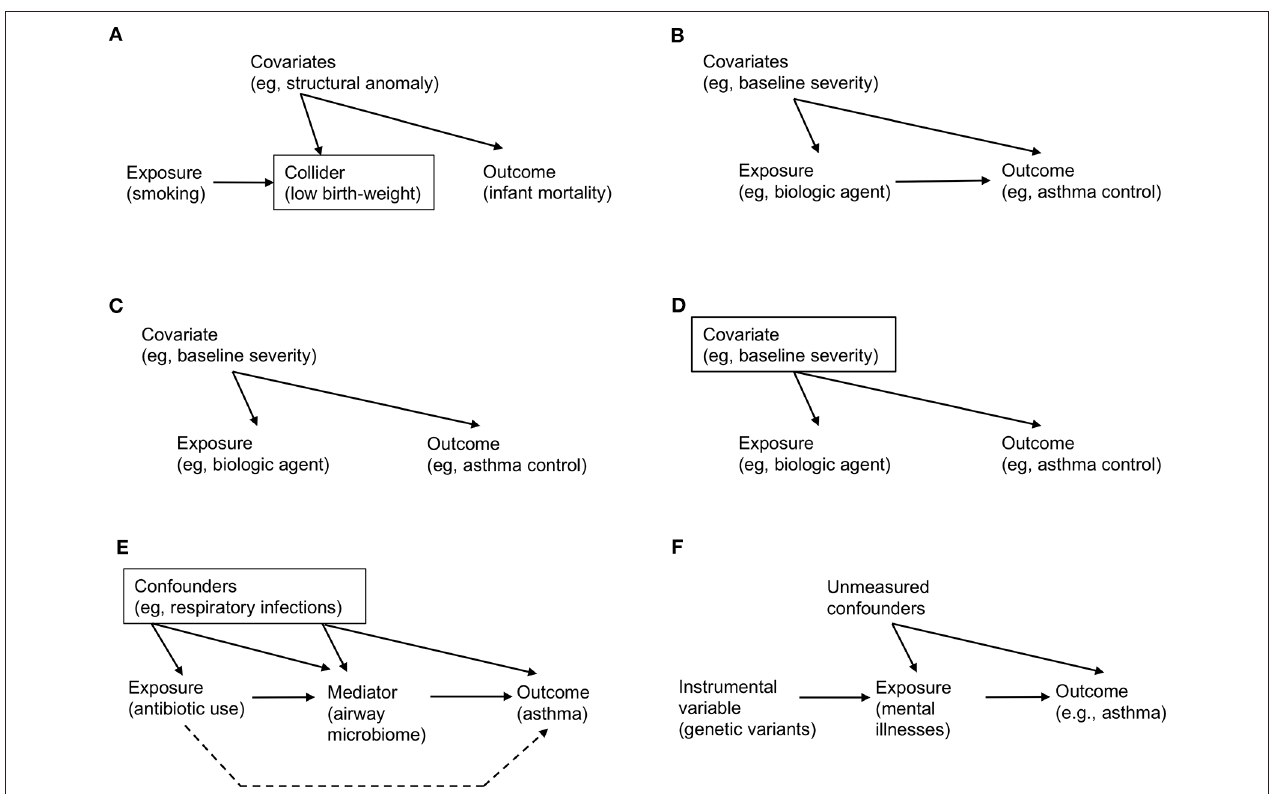
FIGURE 1 | Examples of causal directed acyclic graph that encodes a priori domain knowledge and causal structural hypothesis. (A) Birth-weight paradox. There is no direct arrow from maternal smoking (exposure) to infant mortality (outcome), representing no causal effect. However, association/prediction-mode machine learning algorithm would automatically adjust for variables that are associated both with smoking and mortality (e.g., low birth-weight). Graphically, a rectangle placed around the low-birth weight variable represents adjustment. However, this adjustment for the collider (a node on which two directed arrows “collide”; Table 1 ) opens the flow of association from exposure → collider → covariates (e.g., structural anomaly) → outcome, which leads to a spurious (non-causal) association. (B) Simple example of causal diagram, consisting of exposure (biologic agent), outcome (asthma control), and covariates (e.g., baseline severity of illness). The presence of edge from a variable to another represents our knowledge on the presence of a direct effect. (C) Example of confounding. While there is no causal effect (i.e., no direct arrow from exposure to outcome), there is an association between these variables through the paths involving a common-cause covariate (i.e., a confounder), leading to a non-causal association between the exposure and outcome (i.e., confounding; Table 1 ). (D) Example of de-confounding. This confounding can be addressed by adjusting for the confounder by blocking the back-door path. Graphically, a rectangle placed around the confounder blocks the association flow through the back-door path. (E) Example of mediation. The causal relation between the exposure (systemic antibiotic use), mediator (airway microbiome), and outcome (asthma development). The confounders (e.g., acute respiratory infections) between the exposure, mediator, and outcome should be adjusted. The indirect (or mediation) effect is represented by the path which passes through the mediator. The direct effect is represented by the path which does not pass (the broken line; Table 1 ). (F) Example of mendelian randomization. Genetic variants that are strongly associated with the exposure of interest (mental illnesses) function as the instrument variable. Note that there is no association (or path) between the genetic variants and unmeasured confounders (i.e., independent condition) and that the genetic variants affect the outcome only through their effect on the exposure (i.e., exclusion restriction condition; Table 3